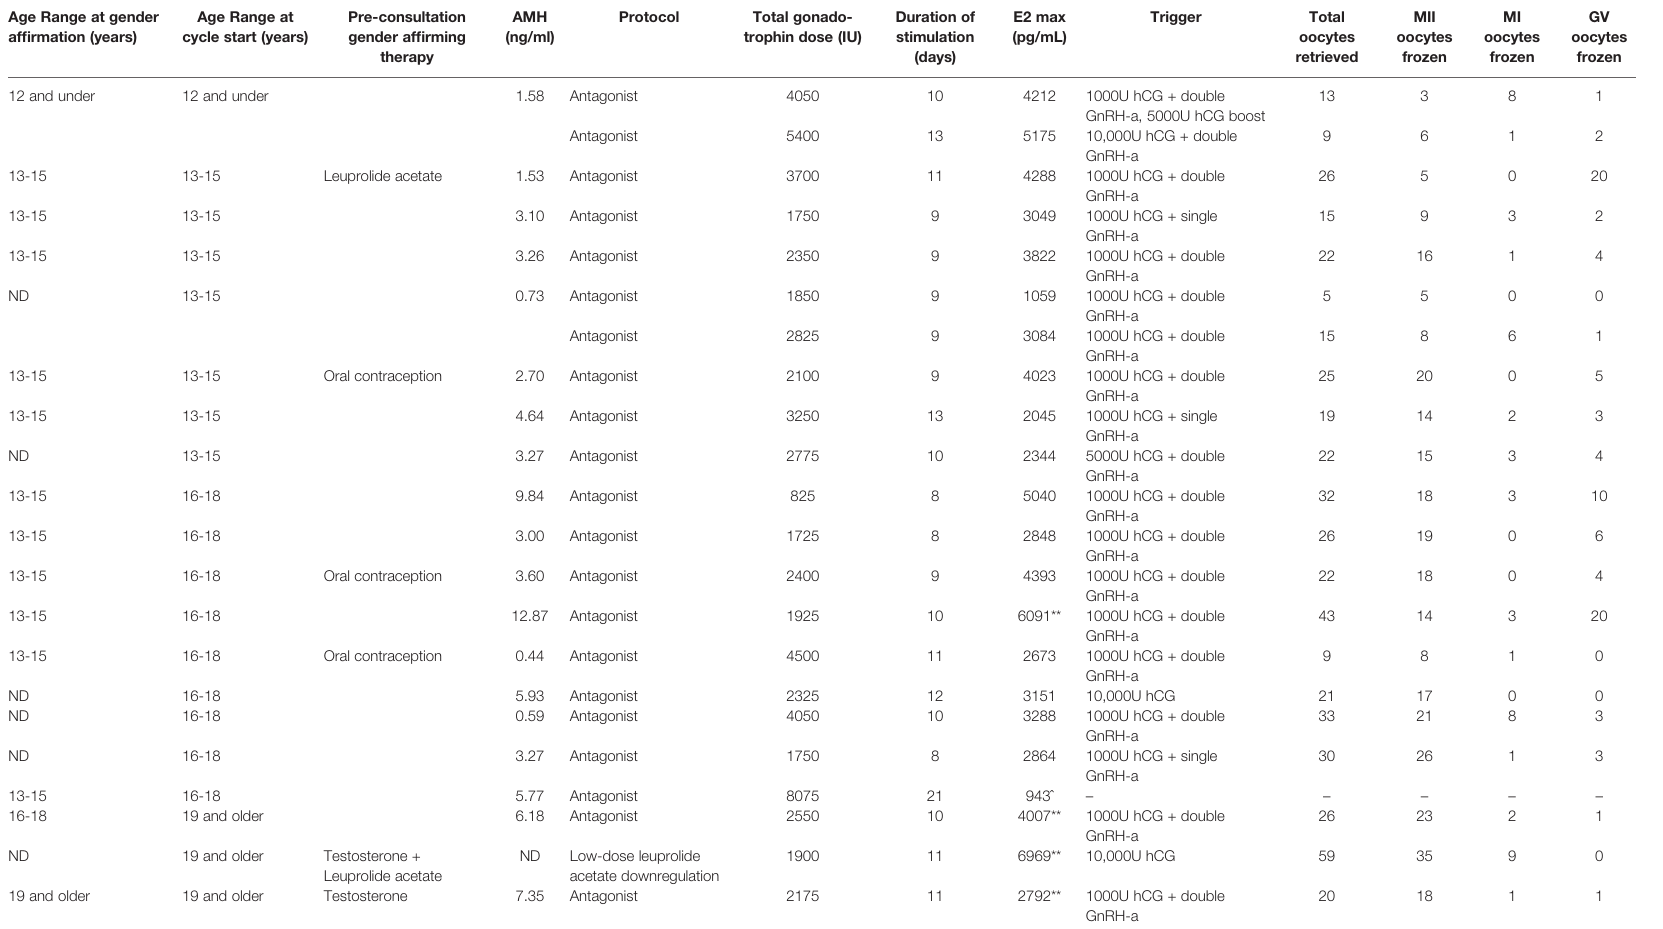
TABLE 3A | Oocyte Cryopreservation Outcomes for Individual AYA Transmale Cycles. Age Range at gender af fi rmation